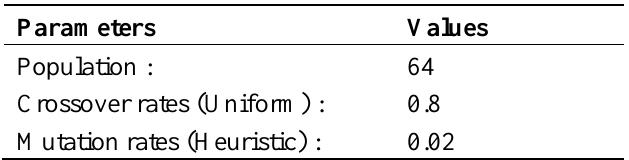
Table 2. The Fixed Parameters for the Genetic